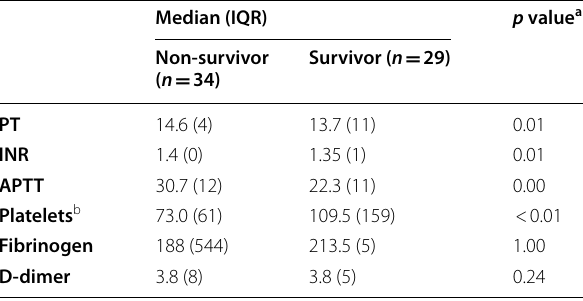
Table 3 Comparison of disease outcomes among COVID-19 patients on the basis of serum platelets and coagulation profile ( n =